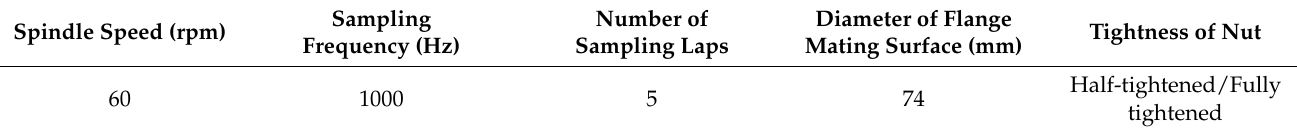
Table 2. Single-factor experimental parameters of nut tightness. Table 3. Single-factor experiment of three-jaws aligning.